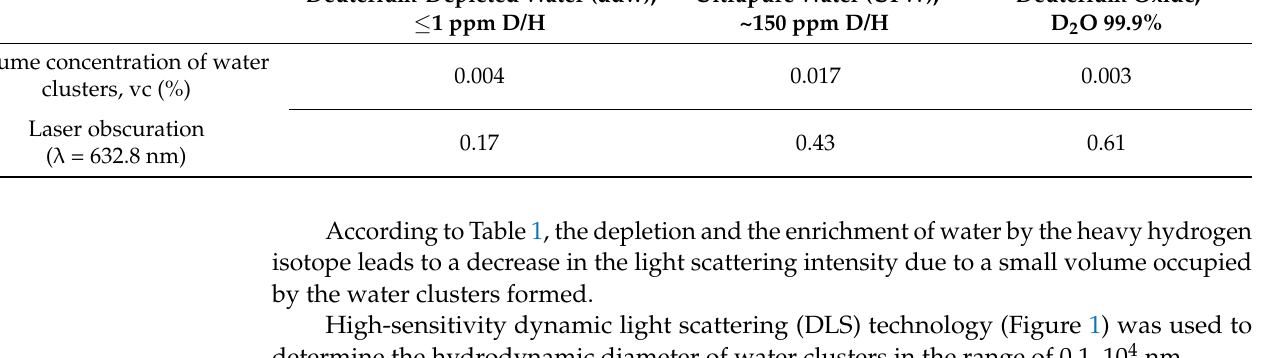
Table 1. Data on laser light scattering in water samples with different contents of stable hydrogen isotopes. Values LALLS Data Deuterium-Depleted Water (ddw), Ultrapure Water (UPW), ≤ 1 ppm D/H ~150 ppm D/H Volume concentration of water 0.004 clusters, vc (%) Laser obscuration ( λ = 632.8